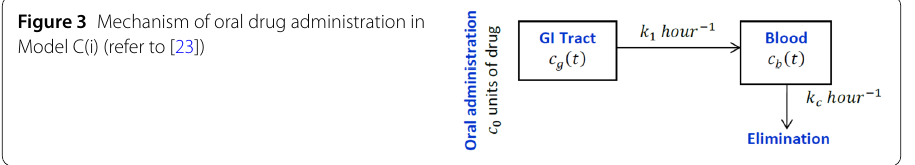
Figure 3 Mechanism of oral drug administration in Model C(i) (refer to